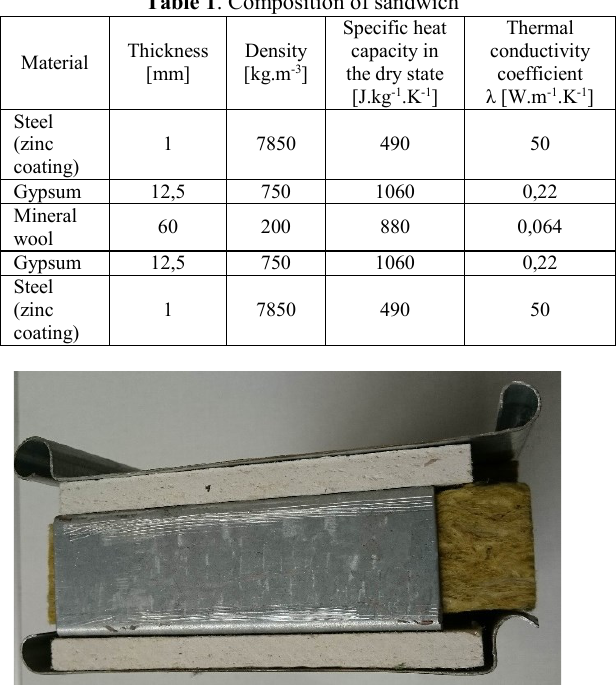
Fig. 1. Cross section of the lamella